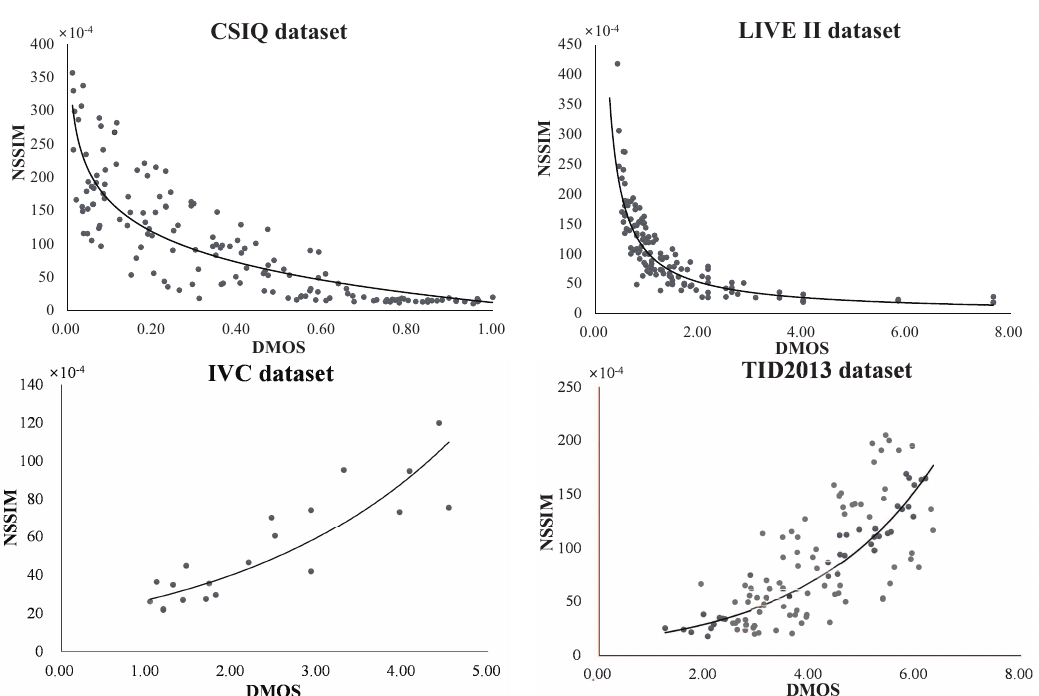
Figure 8. Scatter plots of DMOS vs NSSIM predicted scores on four datasets.